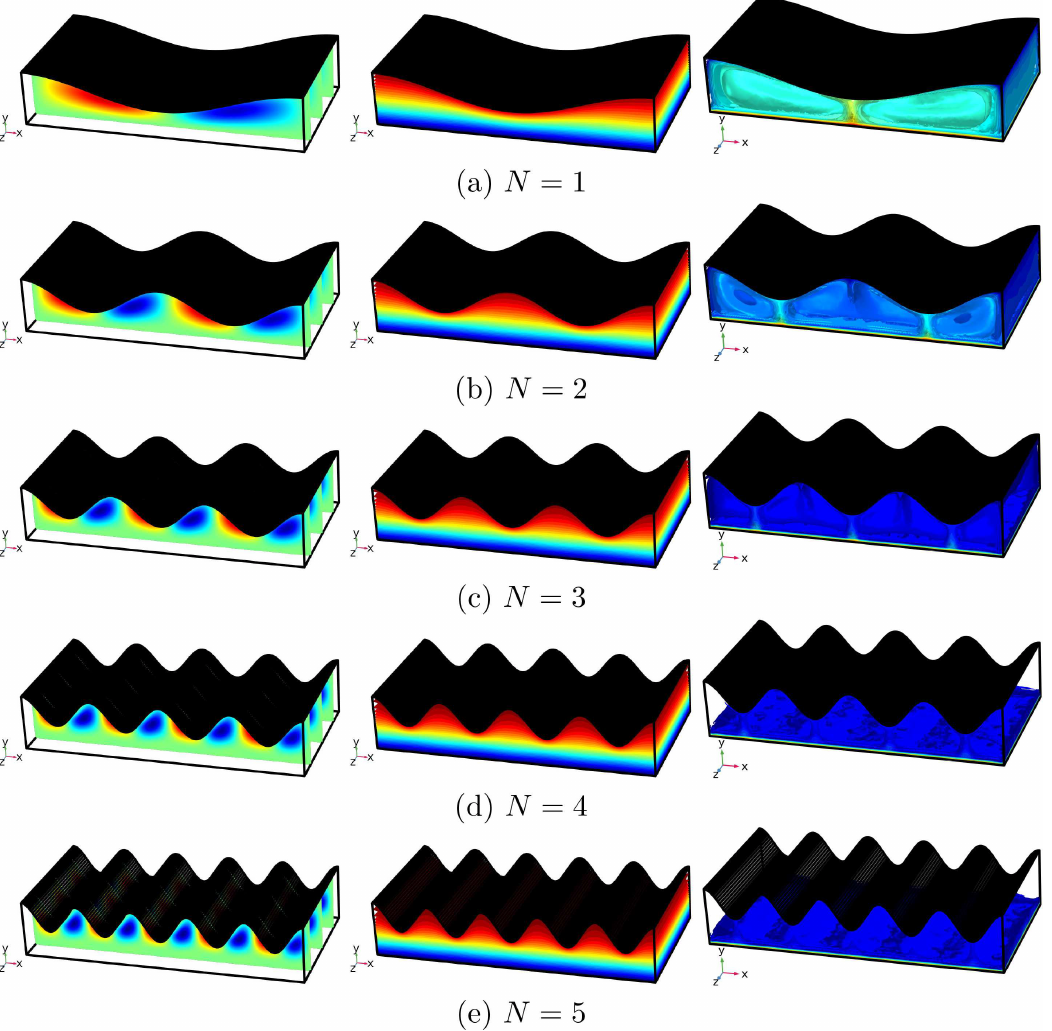
Figure 5. Variation of the 3D streamlines ( left ), isotherms ( middle ), and nanoparticle distribution ( right ) evolution by number of oscillations ( N ) for A = 0.1, Ra = 10 6 , and φ =